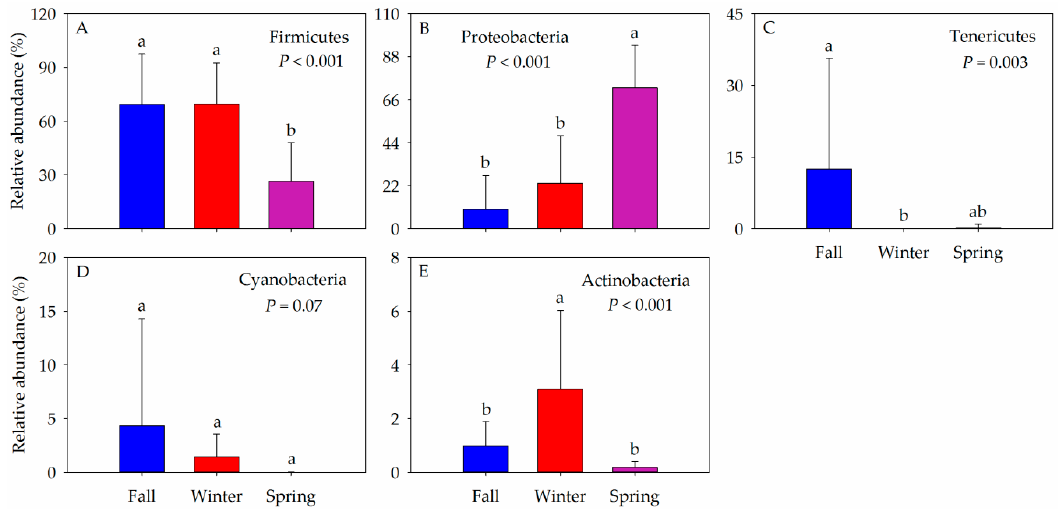
Figure 3. Relative abundance of the dominant bacterial phyla in three seasons. ( A ) Firmicutes, ( B ) Proteobacteria, ( C ) Tenericutes, ( D ) Cyanobacteria, and ( E ) Actinobacteria. Di ff erent letters represent significant di ff erences in Tukey’s HSD comparisons ( P < 0.05). Bars represent mean; error bars indicate standard deviation.